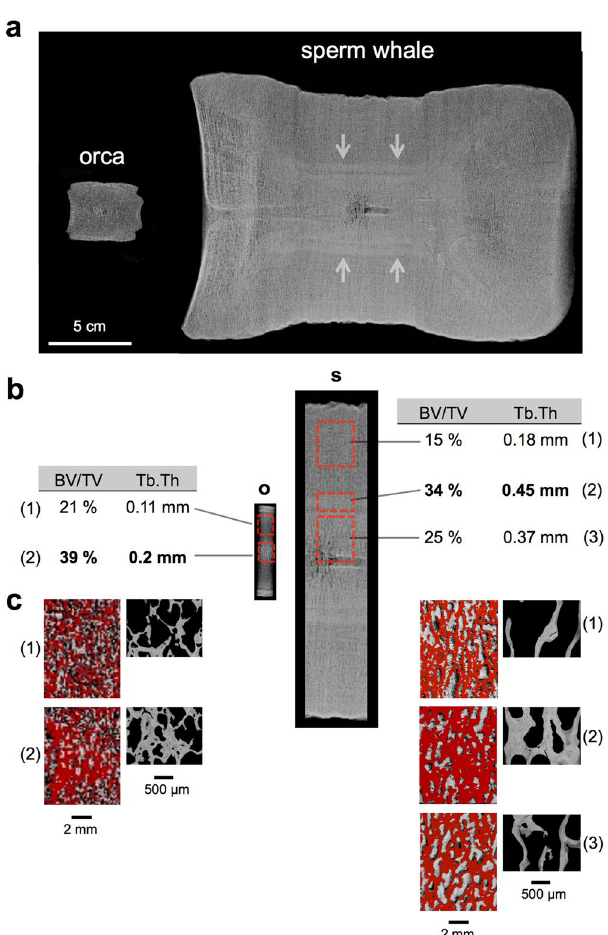
Figure 2. Central bone densification (bone-within-bone) in orca and sperm whale. ( a ) Orcas and sperm whales show a central ossification zone with contact radiography (midsagittal slice of 0.8 cm). Note the dimensions of the vertebral bodies. ( b ) Punch biopsies from endplate to endplate were taken. In the orca (o) and sperm whales (s), further quantification of the different regions of interest (red boxes) using HR-pQCT revealed an increased bone volume fraction (BV/TV) with thicker trabeculae (Tb.Th) in the central parts, and it corresponded to the “bone-within-bone” structure seen in radiographies. ( c ) Representative images of the scanned subregions in HR-pQCT indicate that the trabecular network was denser in the central